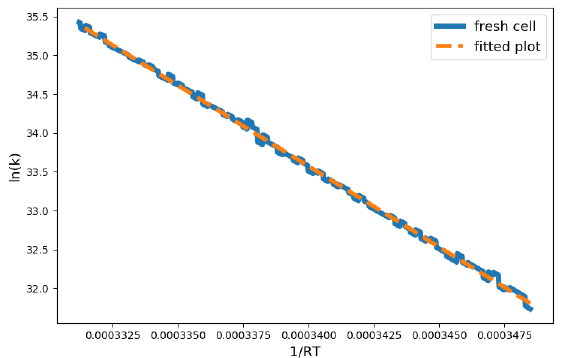
Figure 2. Estimation of E a and A for fresh cell data: ln ( k ( T )) = ln ( A ) − E a